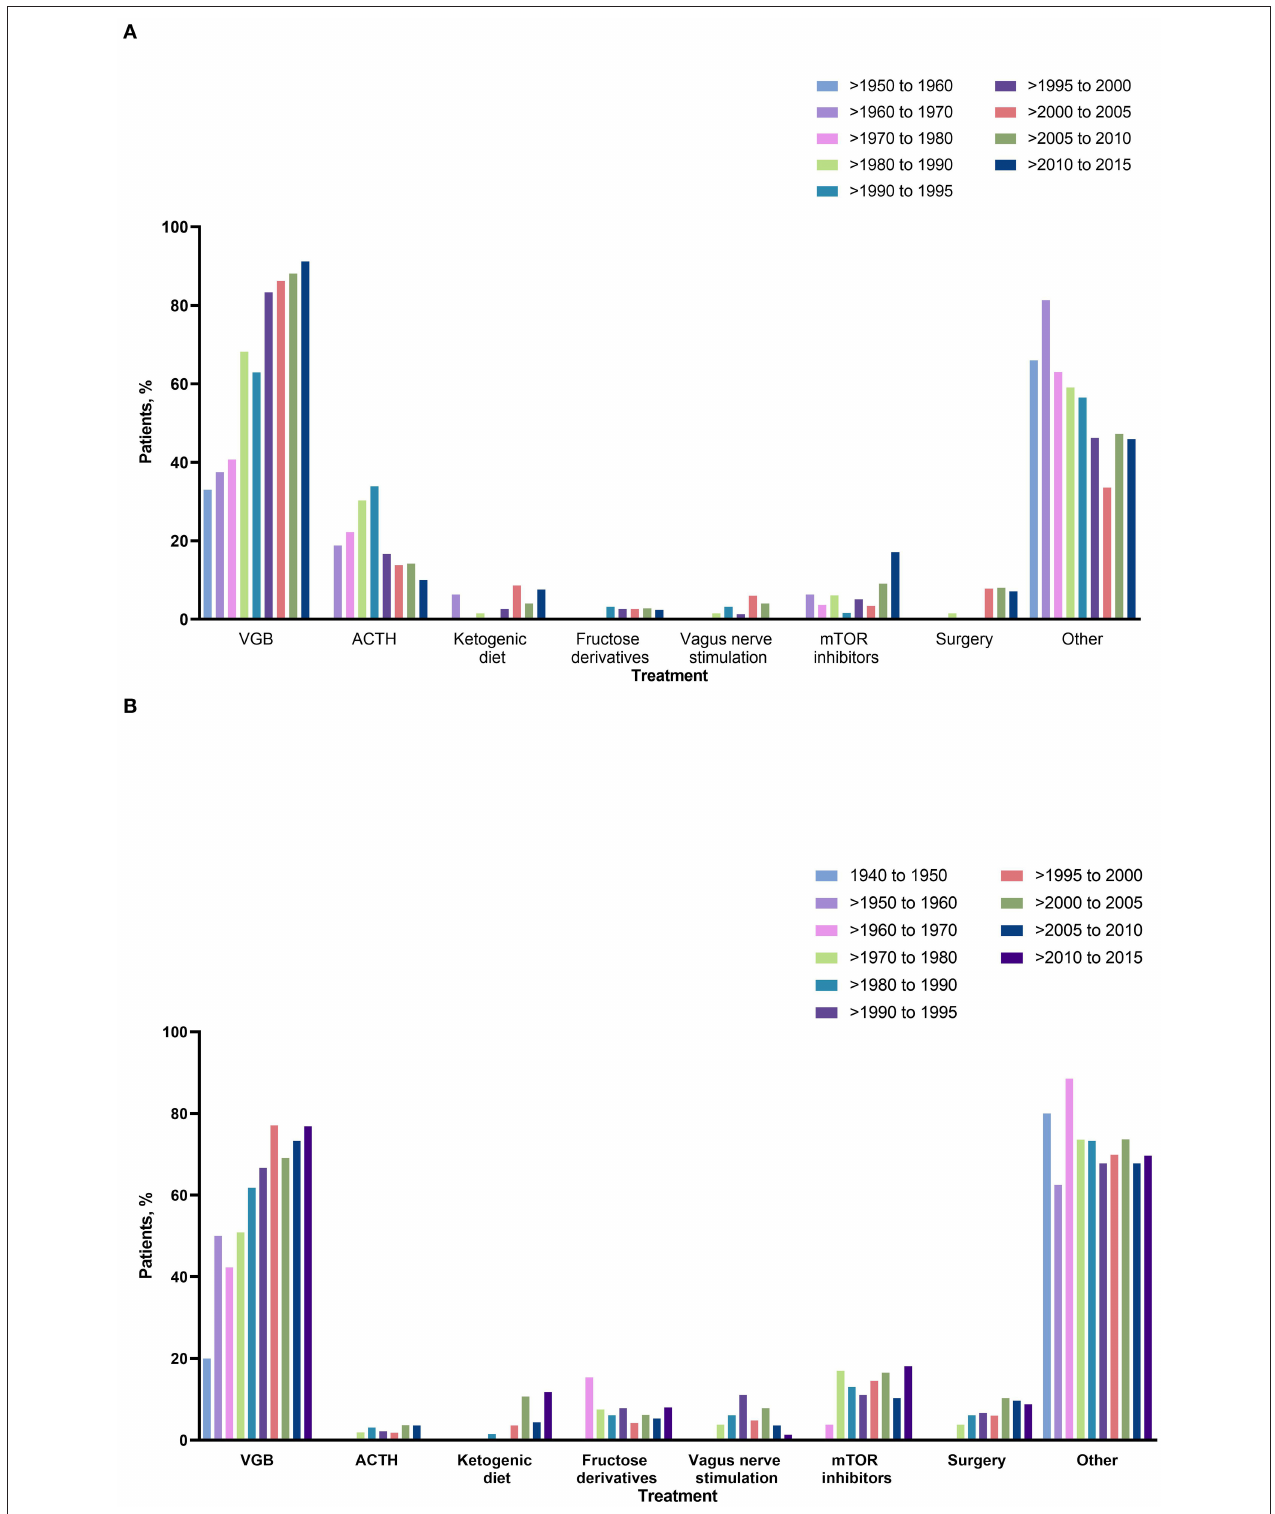
FIGURE 2 | Types of intervention over time in individuals with (A) infantile spasms and (B) focal seizures. ACTH, adrenocorticotropic hormone; mTOR, mammalian target of rapamycin; VGB, vigabatrin.